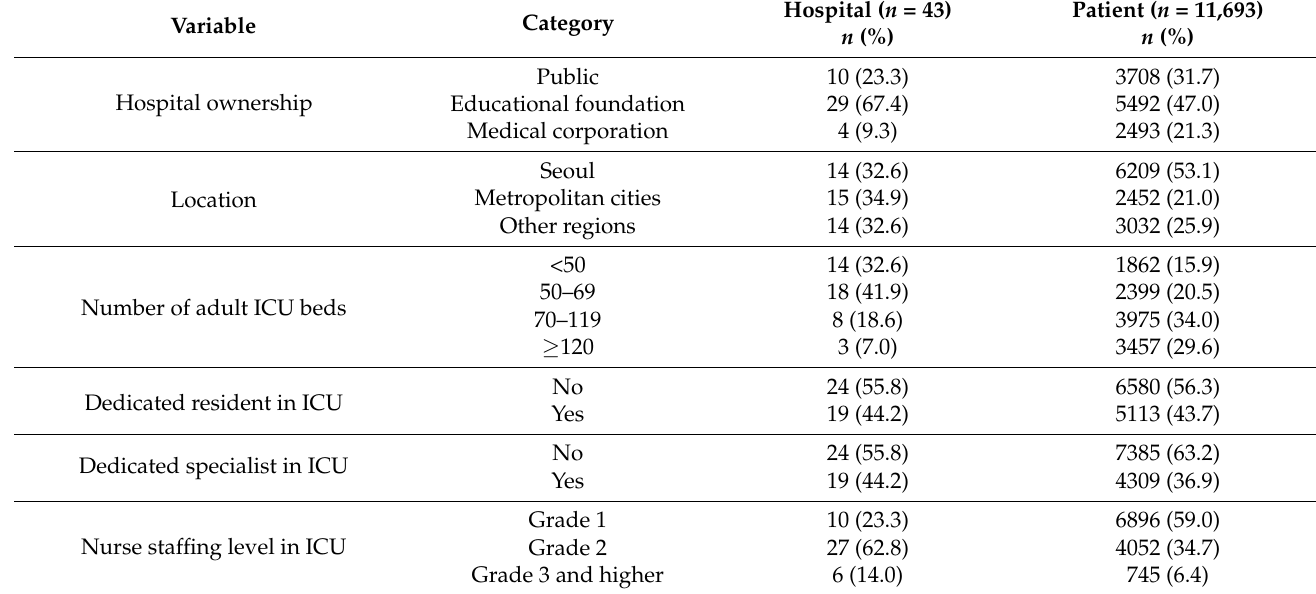
Table 2. Hospital and patient distribution by institutional characteristics.